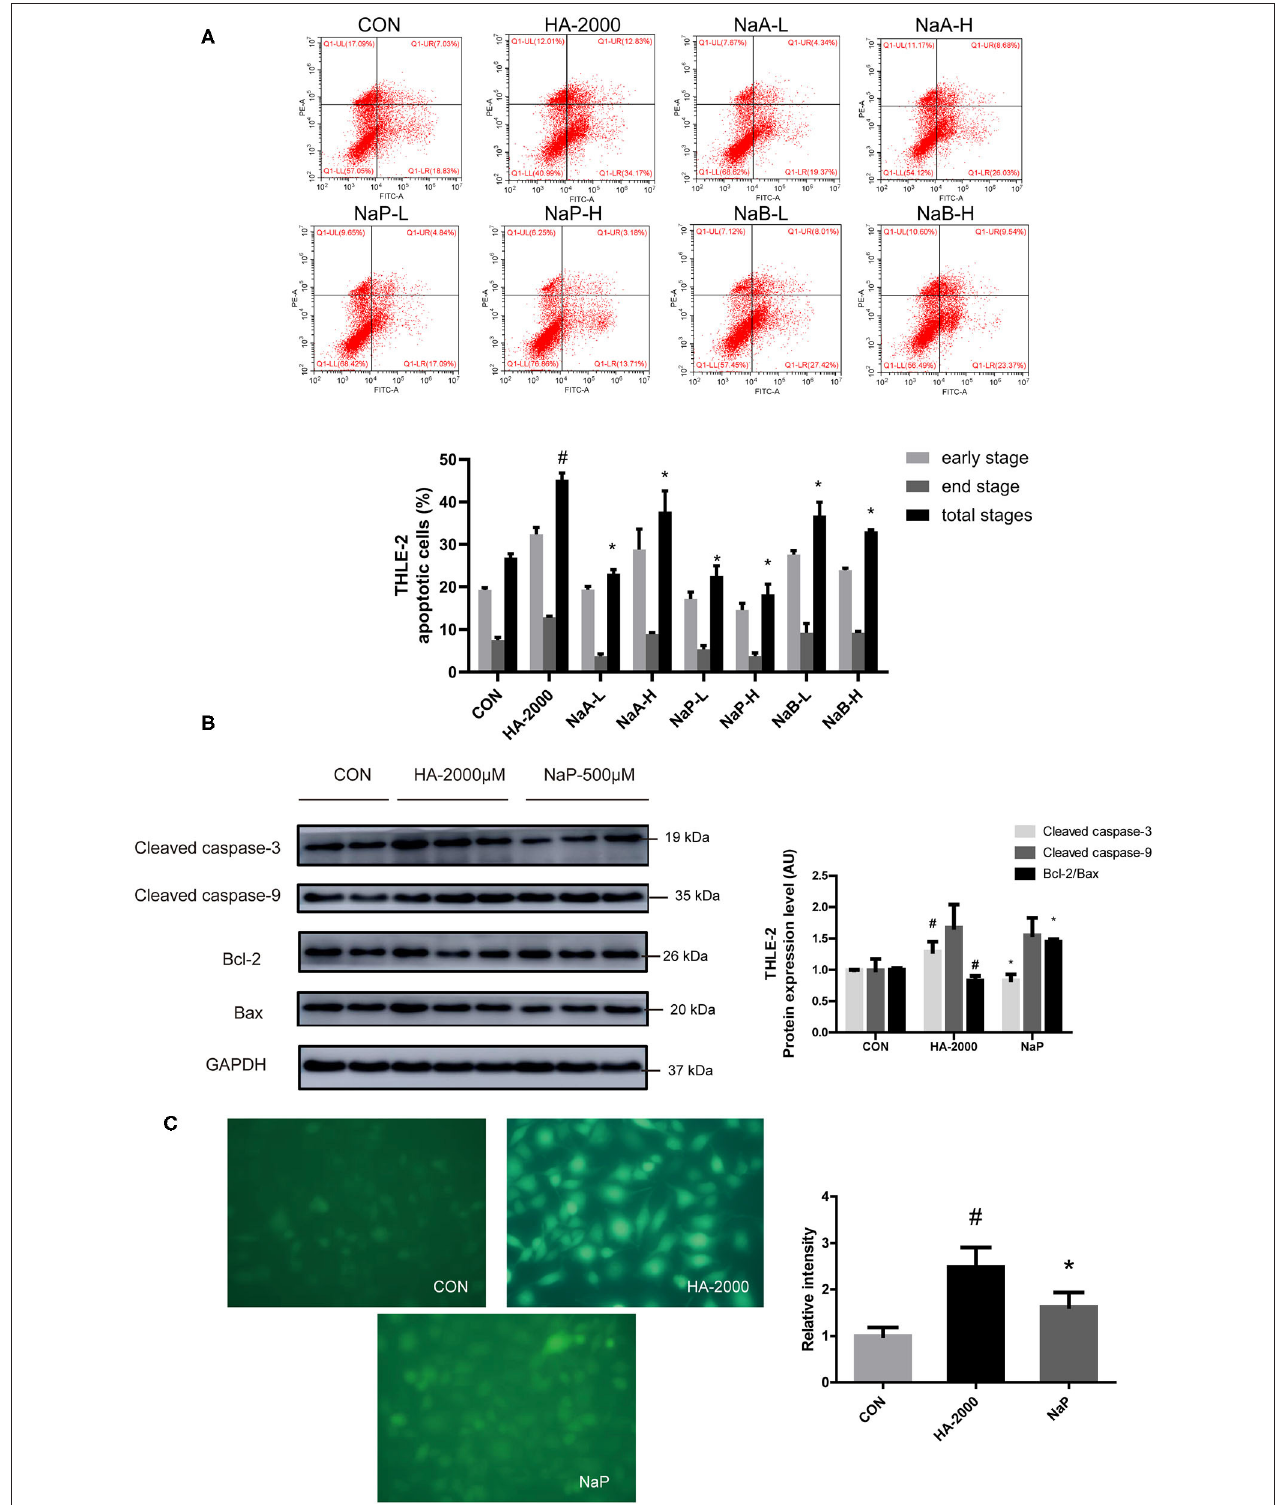
FIGURE 5 | SCFA improved PBUT-induced apoptosis in THLE-2 cells. (A) Effects of SCFAs on HA-induced apoptosis in THLE-2 cells ( n = 3). CON, control group. HA-2000, 2000 µ M. NaA-L, 500 µ M sodium acetate. NaA-H, 5000 µ M sodium acetate. NaP-L, 50 µ M sodium propionate. NaP-H, 500 µ M sodium propionate. NaB-L, 50 µ M sodium butyrate. NaB-H, 500 µ M sodium butyrate. (B) Propionate improved HA-induced apoptosis protein expression in THLE-2 cells ( n = 2-3). (C) Propionate improved HA-induced ROS production in THLE-2 cells ( n = 3). For all bar graphs, the data are the mean ± SD. #, P < 0. 05 vs. CON group. *, P < 0. 05 vs. HA-2000 group. The significant difference was assessed using the one-way ANOVA followed by LSD posttests.